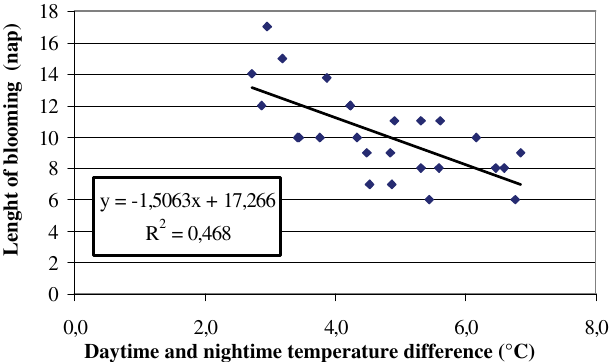
Figure 8 . Relationship between the lenght of blooming and average value of daytime and nightime temperature difference during the bloming at “Újfehértói fürtös” cultivar (Újfehértó 1983–2008)